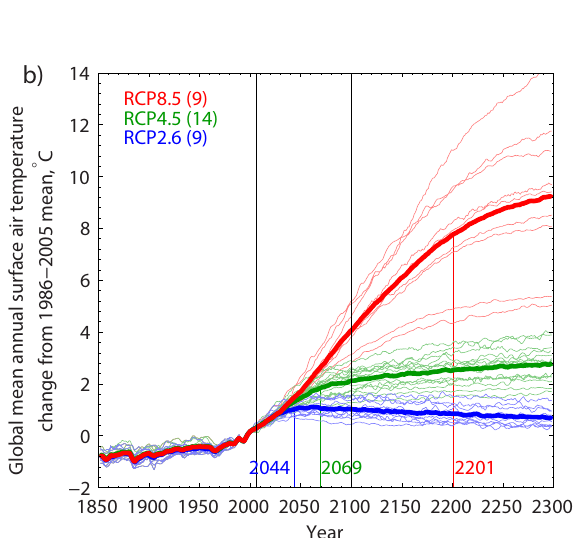
Figure 1. (a) Time series of forcing (W m − 2 ) under each of the extended RCP scenarios for RCP2.6, RCP4.5, and RCP8.5. His- torical forcing (black) covers the period 1850–2005, and the RCPs and extended RCPs are continued from 2006 and 2100. The year in which the forcing reaches its 11-year maximum (RCP2.6) or 97% of its maximum is shown by vertical lines (RCP4.5, RCP8.5). Data from Meinshausen et al. (2011). (b) Time series of annual global mean surface air temperature for RCP2.6 (blue), RCP4.5 (green), and RCP8.5 (red). Multi-model means are shown as dark solid lines, and lighter lines indicate individual ensemble members (5-year run- ning mean). The number of models for each RCP is given in paren-